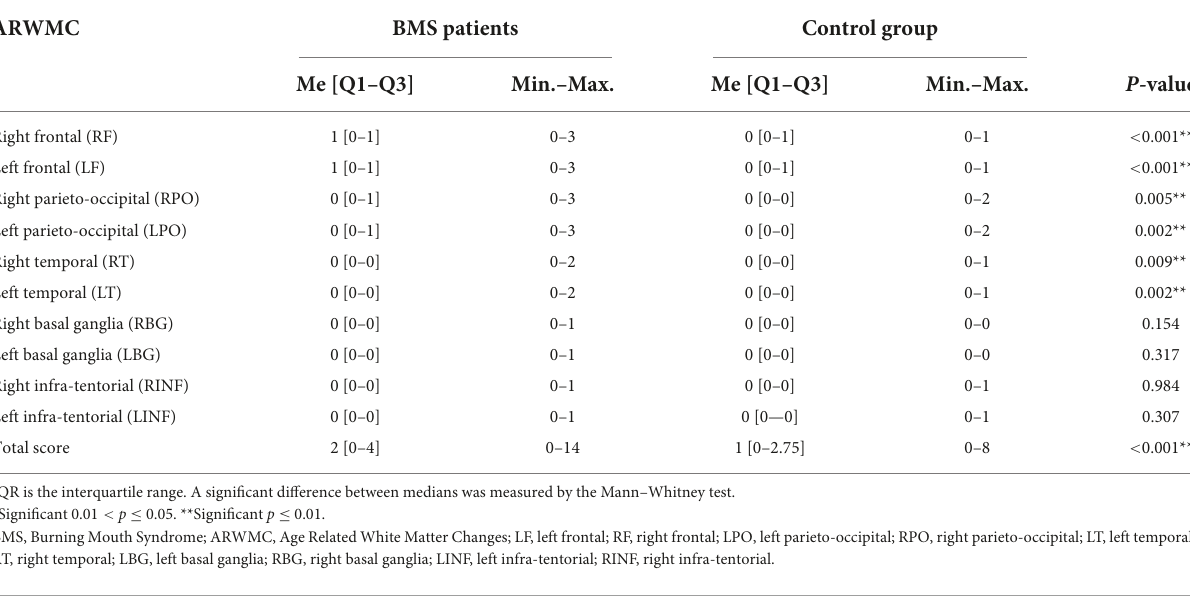
TABLE 3 Analysis of the ARWMC scores of the patients with BMS and the healthy controls.